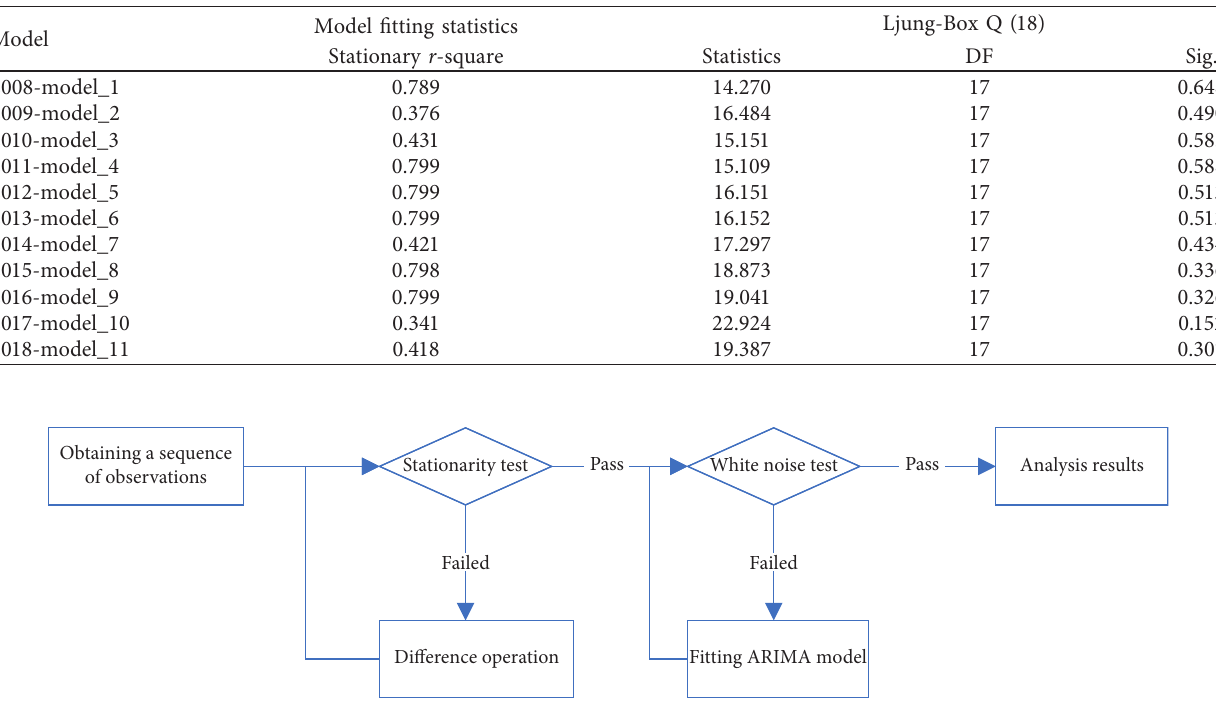
Figure 2: Operation process of ARIMA model. Table 2: Fitted